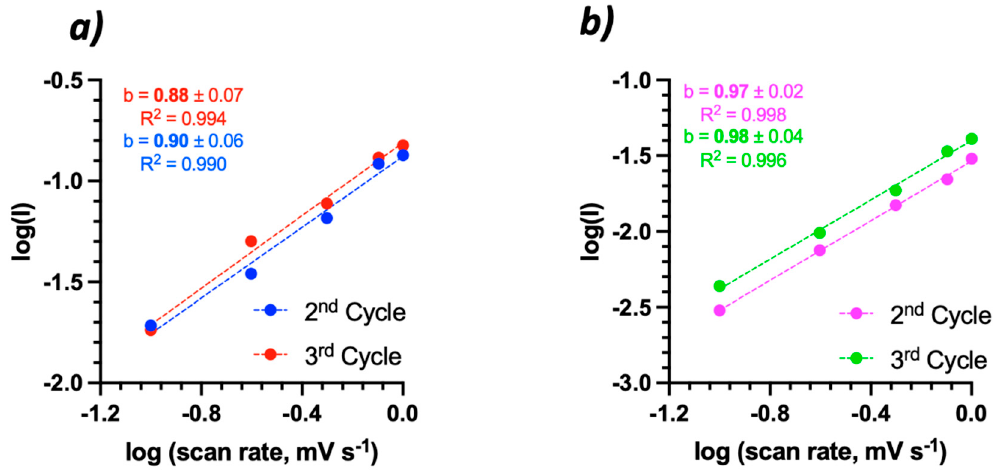
Figure 7. Log-scale plots of Bi 2 Se 3 thin films in 1 M NaNO 3 : ( a ) Na + intercalation; ( b ) Na + deinterca-